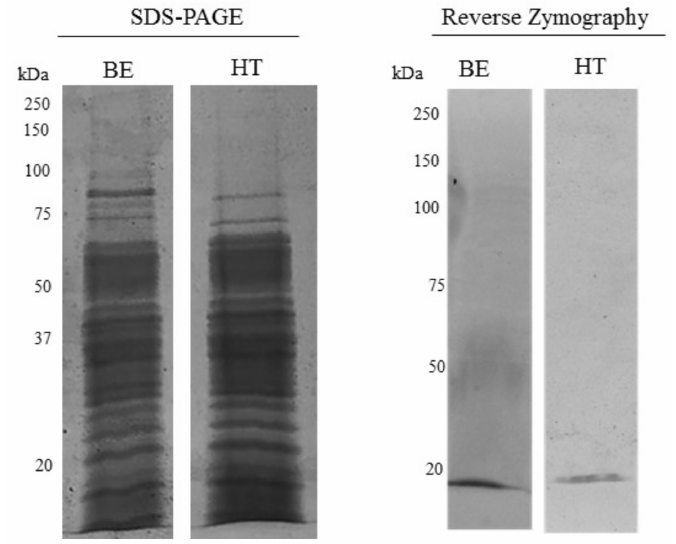
Figure 1. MMPI activity in L. albus resists heat treatment. The images of the polypeptide distribution between Lupinus albus seeds simply extracted with buffer (buffer extraction; BE) or after heat treatment (HT), and visualized by SDS-PAGE ( left ) or by reverse gelatin zymography ( right ). Each well was loaded with 50 µ g.mL − 1 of protein extracts in a 17.5% ( w / v acrylamide) polyacrylamide gels. In the case of reverse zymography, the gels were copolymerized with gelatin and